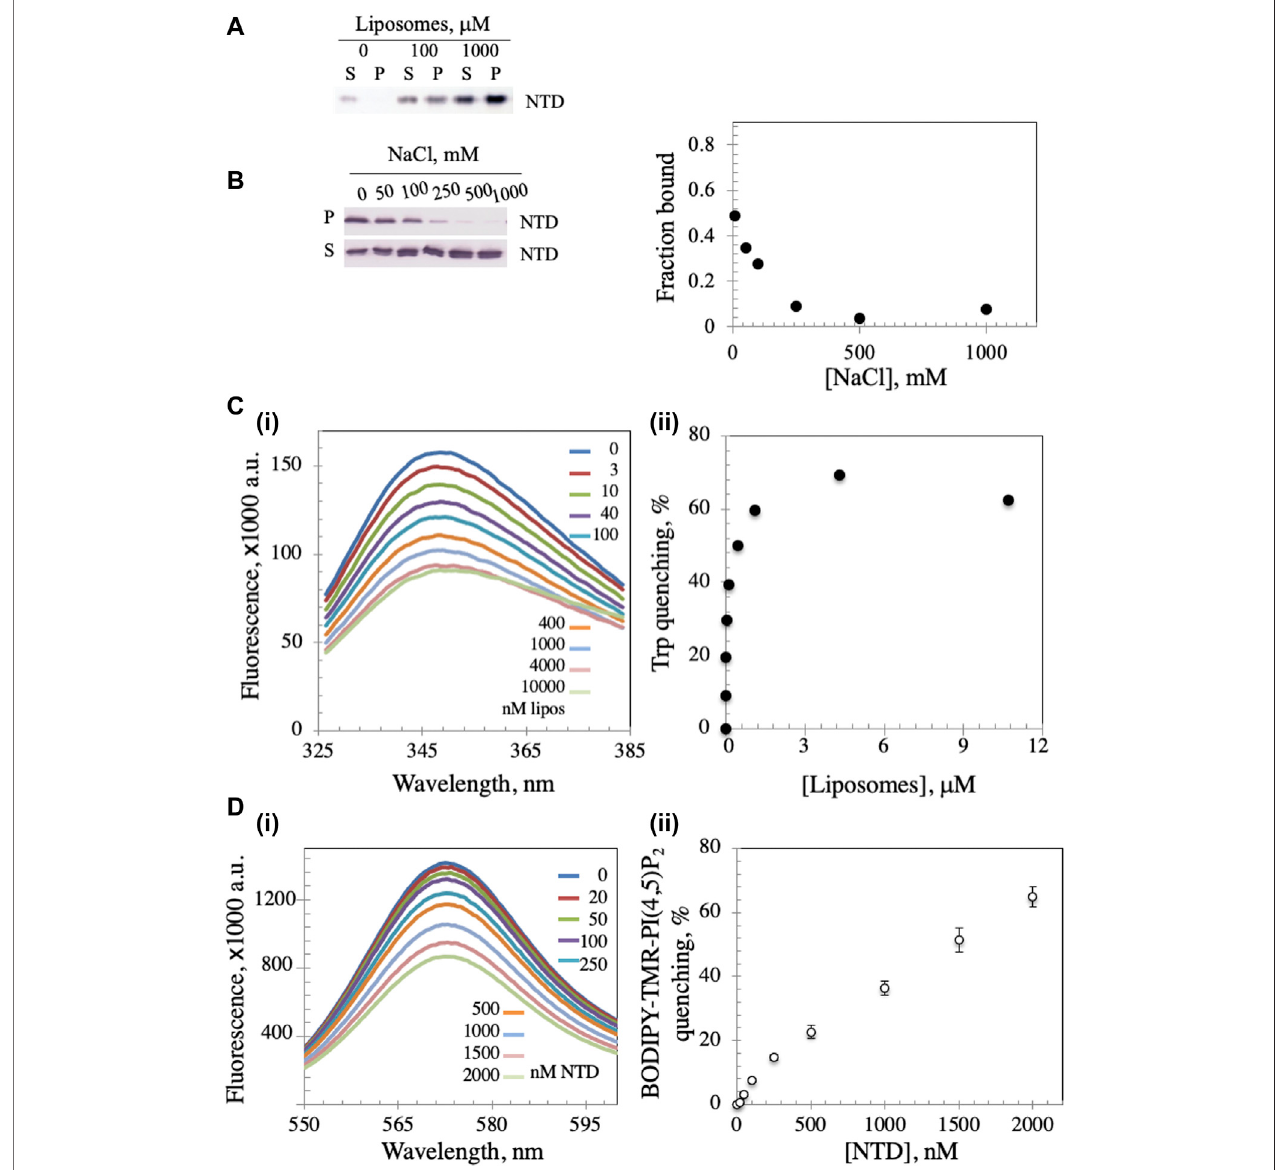
FIGURE2 | Dm NTD exhibit membrane binding properties. (A) In the liposome cosedimentation assay, 0.4 μ M NTD wasmixed with increasing liposome amounts and sedimented by ultracentrifugation (see Materials and Methods ). The supernatant (S) and pellet (P) fractions were separated on 12% polyacrylamide gels and visualized by silver staining. (B) Increasing amount of NaCl disrupts liposome-NTD interactions. (C) Tryptophan fl uorescence emission spectra of NTD were measured after sequential addition of different amounts of liposomes (i) . The observed quenching is indicative of liposome binding to NTD. Quantitative representation of the quenching ispresented in (ii) . (D) The fl uorescence spectra ofasolectin liposomes containing 0.5% BODIPY-TMR-PI(4,5)P 2 were measured withincreasing amounts of NTD (i) . In (ii) , the percent quenching is plotted versus protein concentration. The results represent the average and standard deviation of 3 independent experiments.